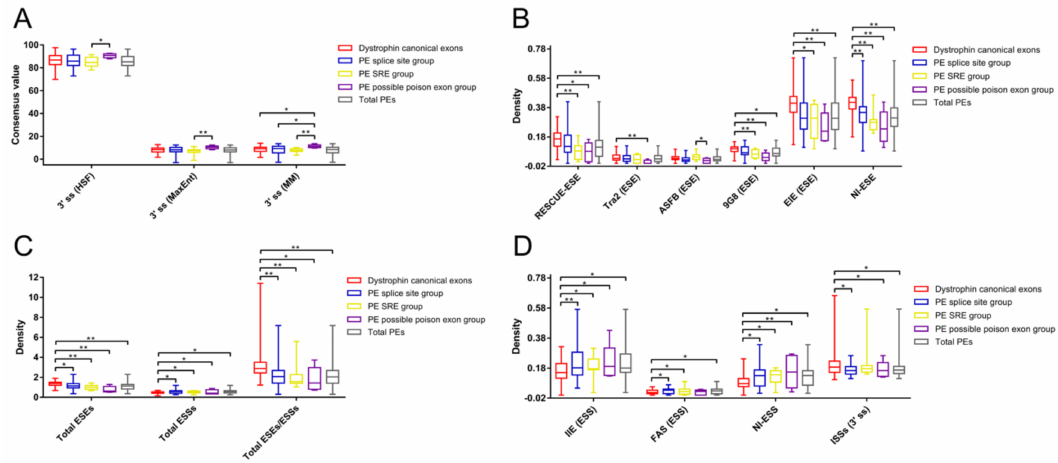
Figure 3. Comparative analyses of di ff erent splicing signals among di ff erent groups of dystrophin pseudoexons and the group of dystrophin canonical exons. Comparative analysis of the 3 (cid:48) ss strength ( A ) revealed that the possible poison exon group had a significantly stronger 3 (cid:48) ss compared to other groups. Comparative analyses of the SREs revealed that di ff erent groups of dystrophin PEs had a smaller density of diverse types of ESEs ( B ), a higher density of several types of ESSs ( D ), and a smaller ratio of total ESEs to total ESSs ( C ) compared to the CEs group. Some groups of dystrophin PEs had a smaller density of 3 (cid:48) ss ISSs compared to the CEs group ( D ). Only splicing signals with significant di ff erence among di ff erent groups were included in these figures. Statistics data of other splicing signals are presented in Table S3. Density was calculated as numbers per base pair. Descriptive statistics are presented as box plots, displaying the minimum, first quartile, median, third quartile, and maximum. PE, pseudoexon; SRE, splicing regulatory element; HSF, Human Splicing Finder; MaxEnt, maximum entropy; MM, first order Markov model; ss, splice site; ESE, exonic splicing enhancers; ESS, exonic splicing silencers; ISS, intronic splicing silencers; EIE, exon-identity element; IIE, intron-identity element; NI, neighborhood inference. * p < 0.05; ** p <